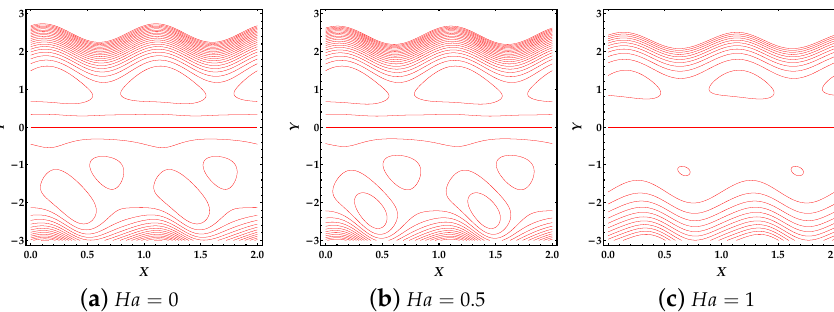
Figure 4. Temperature curves against multiple values of different parameters. ( a ) Ha , ( b ) B r , ( c ) T r .